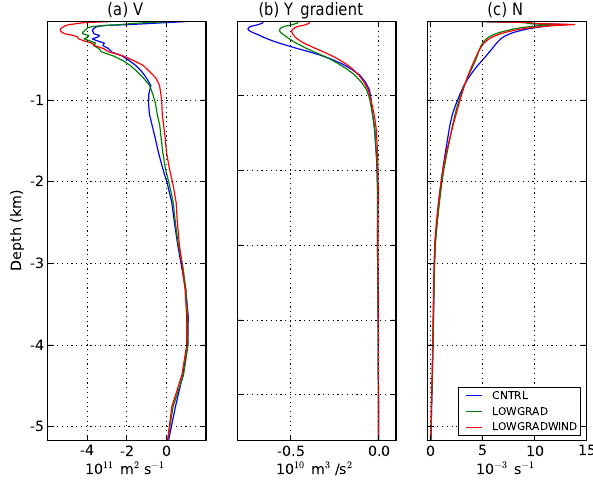
Figure 6. Vertical depth profiles of horizontal mean (south of 30 ◦ N) of (a) meridional velocity u (10 − 4 ms − 1 ), (b) latitudinal ( y ) (kgm − 4 ) and (c) the buoyancy frequency derivative of density ∂ρ ∂y q ∂ρ − g N = (in units s − 1 ) for the control case CNTRL (blue), ρ 0 ∂z the low temperature gradient case LOWGRAD (green), and the low temperature and weak wind case LOWGRADWIND (red). Bottom labels indicate